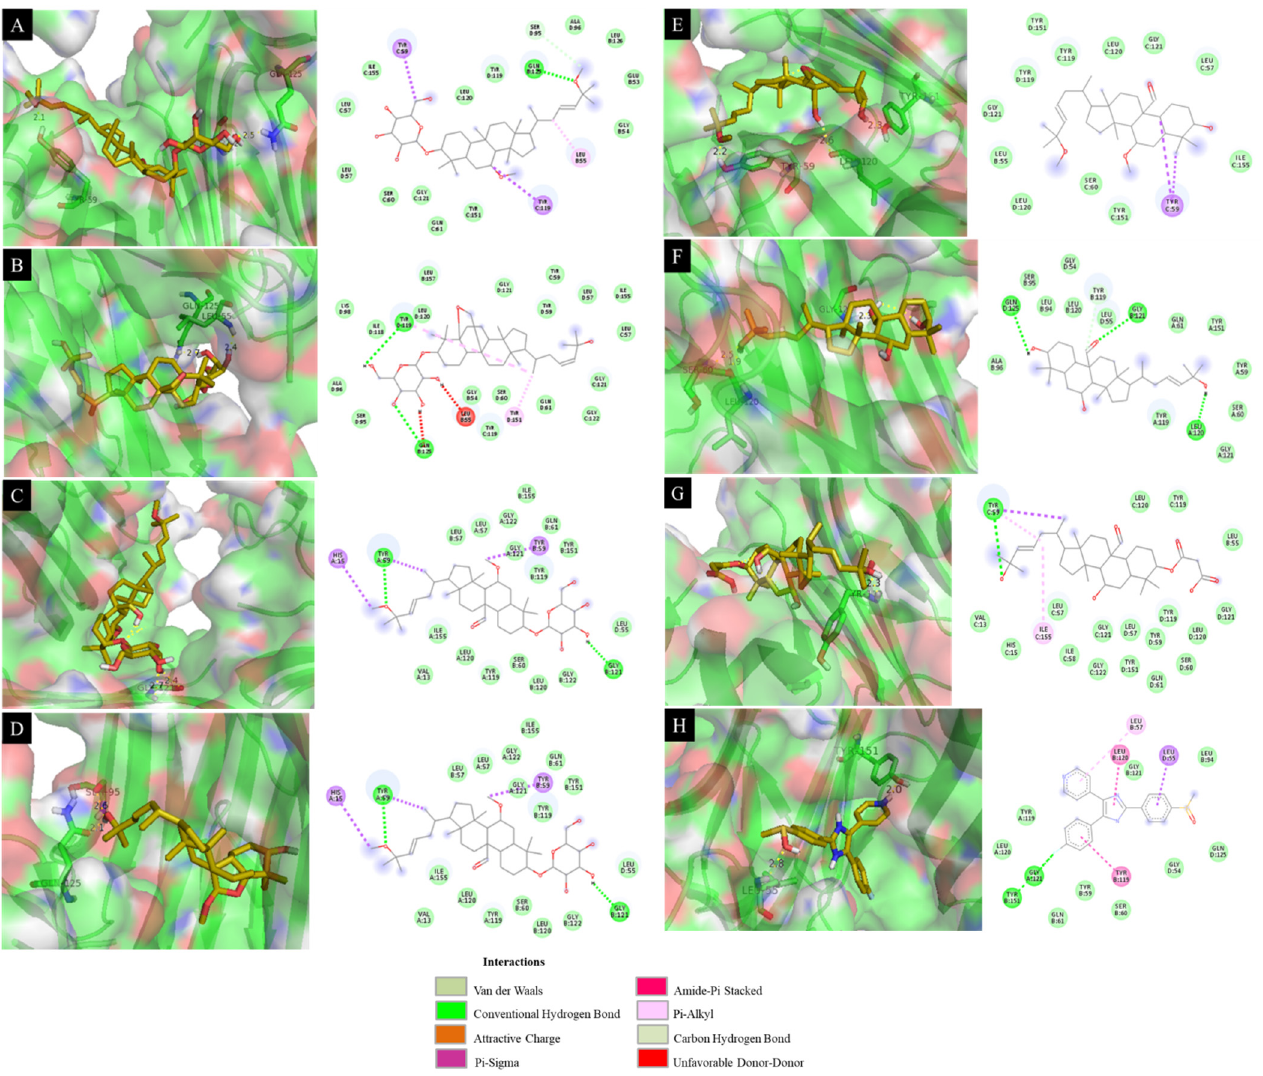
Figure 5. Docking simulation of the interactions between compounds 4 ( A ), 6 ( B ), 9 ( C ), 11 – 14 ( D – G ), and SB203580 ( H ), respectively, and the 2AZ5 protein of TNF- α expression ( A – H ).